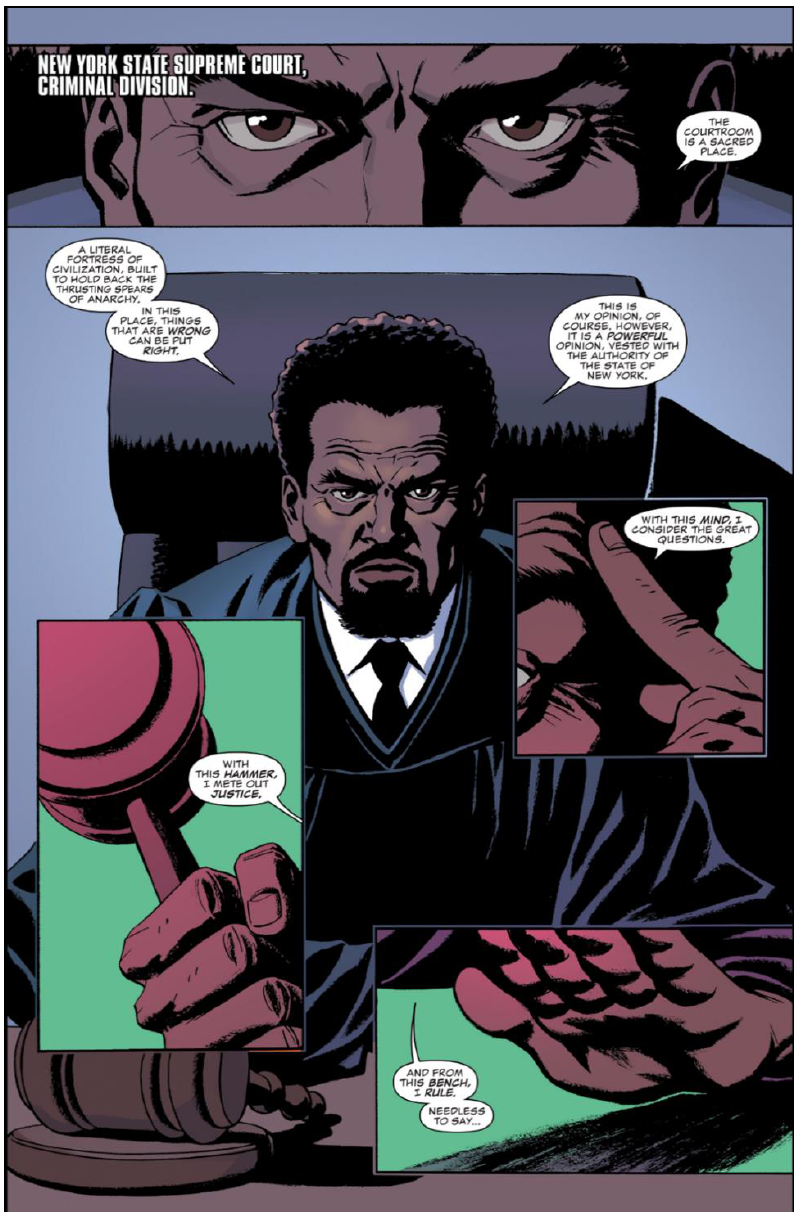
Figure 7. Page from Soule’s Daredevil: Back in Black Vol. 5: Supreme #22, 2017. Image Credit: Goran Sudžuka © 2017 Marvel Characters,